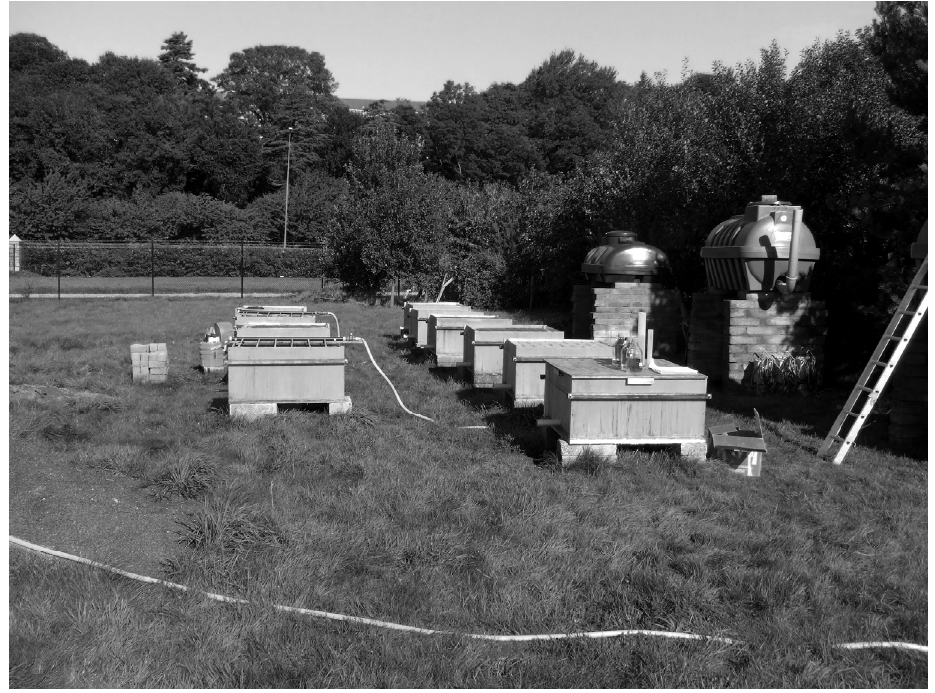
Figure 2. Main experimental set-up used in the “Abertay study” (picture provided by